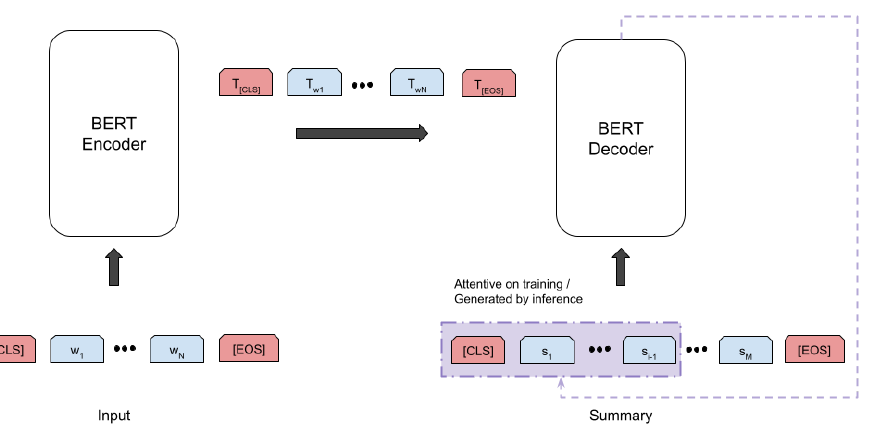
Figure 4. The architecture of the BERT encoder–decoder summarization model we utilized, a two- step process, where the input text is first transformed into contextualized representations and then passed through a decoder to generate a summary. The BERT encoder generates contextualized representations of the input sequence, which are passed to the BERT decoder for generating a summary. Tokens w i (in blue) correspond to words in the input text, while [CLS] and [EOS] (in red) correspond to special tokens. During inference, the decoder takes as the input the output generated so far. During training, the decoder attends to the reference summary up to the token corresponding to each time